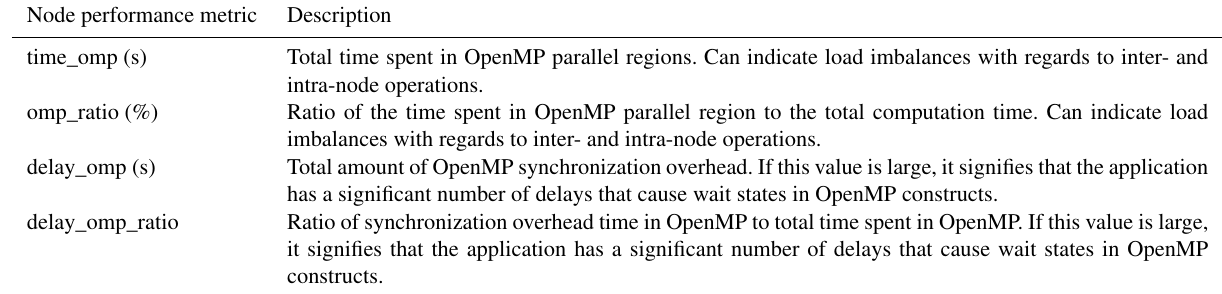
Table B5. Description of performance analysis metrics pertaining to node-level performance currently supported by our RCF. Node performance metric Description